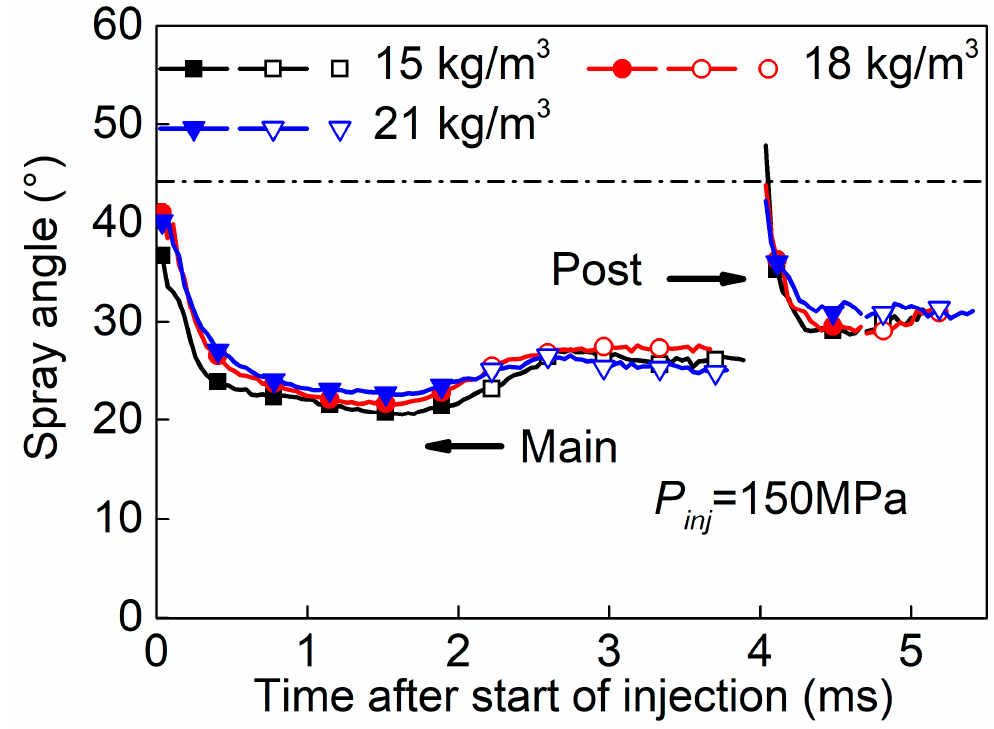
Figure 16. Results of spray angle evolvements with the main-post injection strategy under various surrounding gas densities.